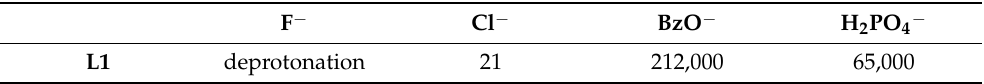
Table 1. Titration data could not be fitted by a 1:1 model. Table 1. Association constants ( K a /M − 1 ) for the formation of the 1:2 adducts of L1 (monitoring the downfield shift of the NH signals attributed to the indole moiety and urea) with anions added